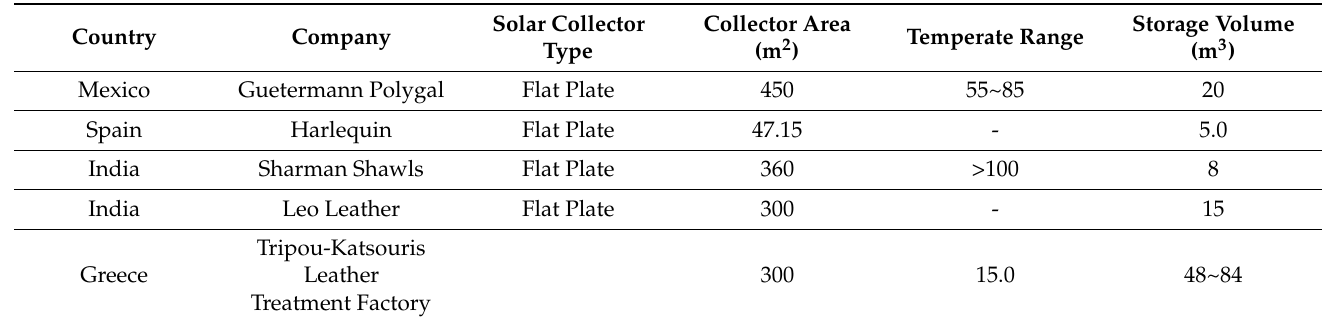
Table 4. Supply level integration for make-up water heating in existing Textile & Leather indus- tries [71].